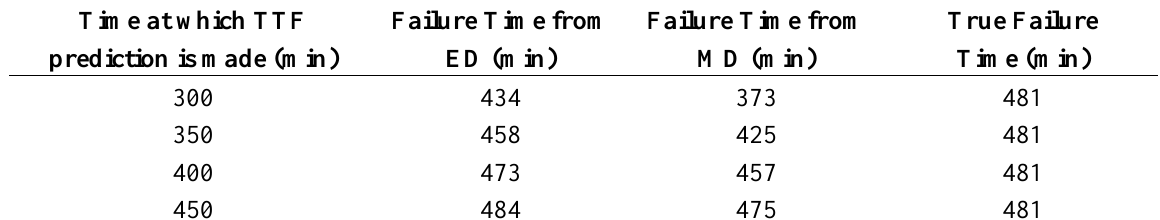
Table 3. Time-to-Failure (TTF) estimation from ED and MD